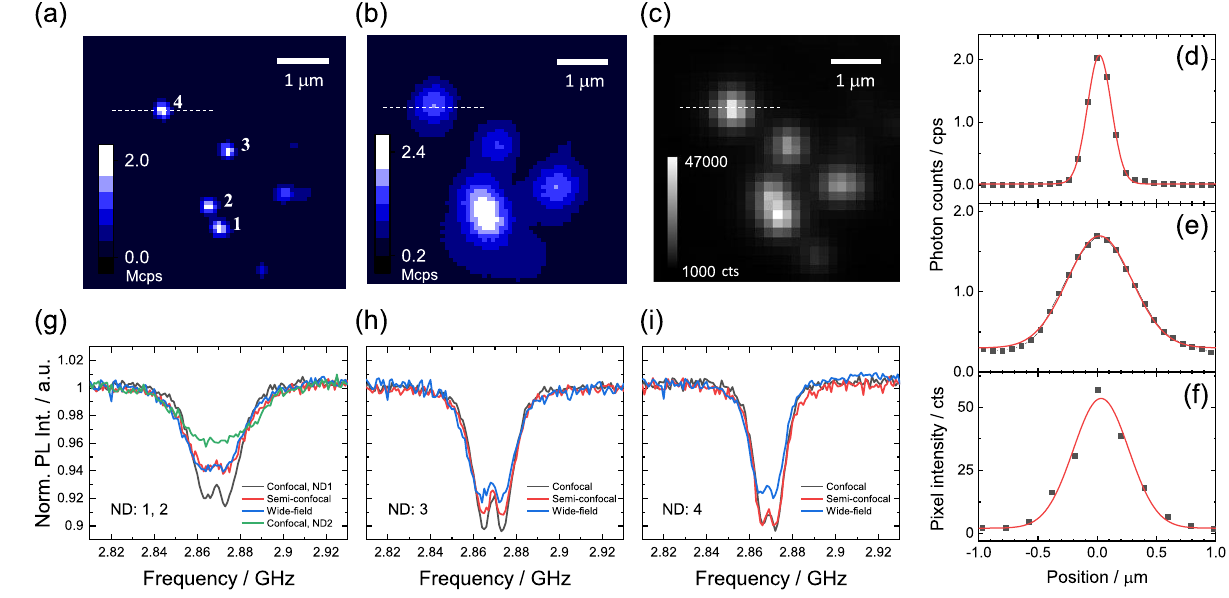
Figure 2. Fluorescence images of the NDs measured using ( a ) confocal scanning, ( b ) semi-confocal scanning, and ( c ) wide-field methods. Cross-sectional plots along the dashed lines in the fluorescence images with the Gaussian fitting curves (red) for ( d ) confocal, ( e ) semi-confocal, and ( f ) wide-field methods. The FWHM values are 0.24, 0.64, and 0.55 µ m , respectively. ODMR spectra measured using the three methods for the designated NDs in Fig. 2, as ( g ) 1 – 2 , ( h ) 3 , and ( i ) 4 . Note that NDs 1 and 2 cannot be spatially resolved using semi- confocal and wide-field detection methods. For the measurements, n acc = 100 , (cid:31) t exp = 10 ms, n pc = 10 , and (cid:31) t = 100 ms were pc